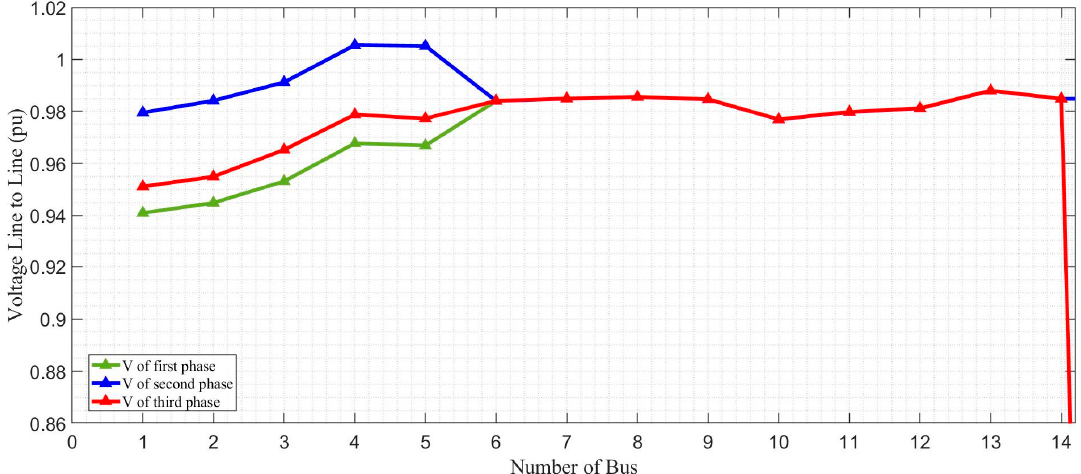
Figure 7. Maximum demand voltage.